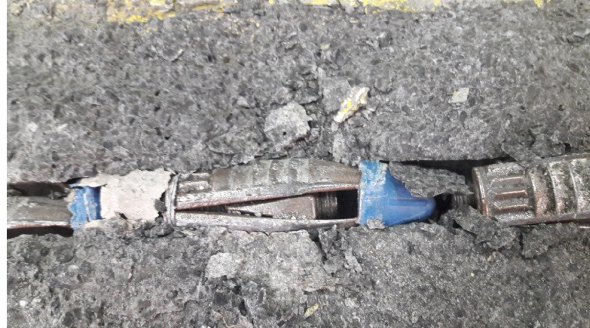
Figure 7: Dismantled concrete block with fixed KE-3W shells after tensile testing.